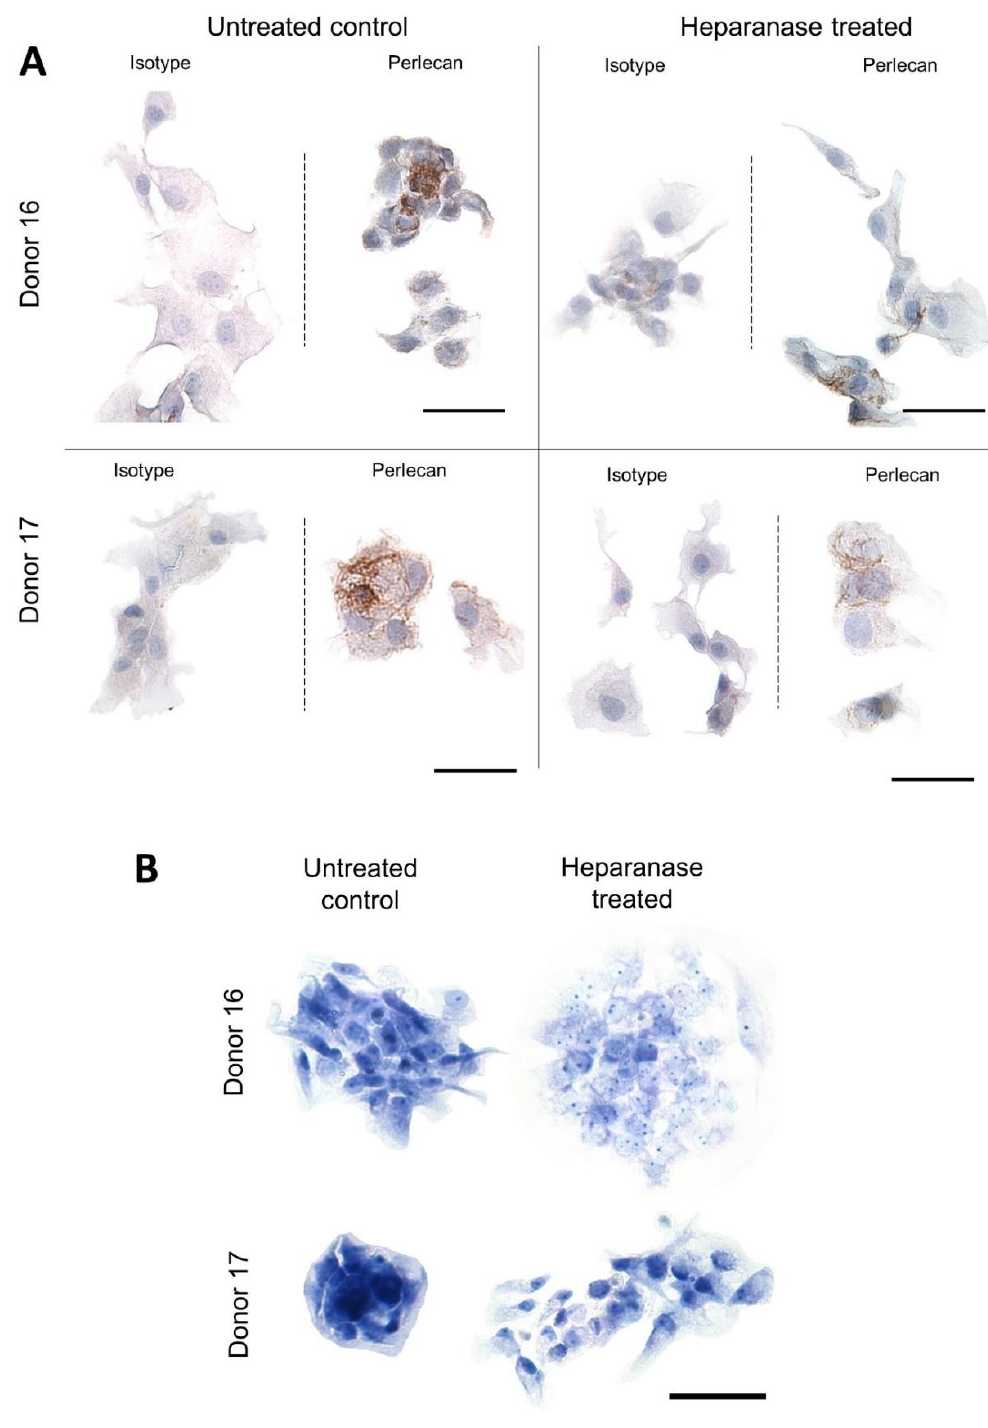
Figure 8. Immunocytochemistry and toluidine blue staining of heparanase-treated chondrocytes (two representative donor examples shown). ( A ) Chondrocytes cultured in chamber slides were treated with heparanase for 48 h and stained for perlecan ( n = 4). Chondrocytes in untreated controls tended to remain in clusters that stained more intensely for perlecan compared to heparinase-treated chondrocytes. ( B ) Toluidine blue staining revealed no noticeable trend. However, cell clusters in both controls and heparanase conditions had stronger staining than individual cells. Scale bars = 50 µm. Metachromasia with toluidine blue staining for glycosaminoglycans was mostly weak with no consistent difference in pattern between control and heparanase condi-